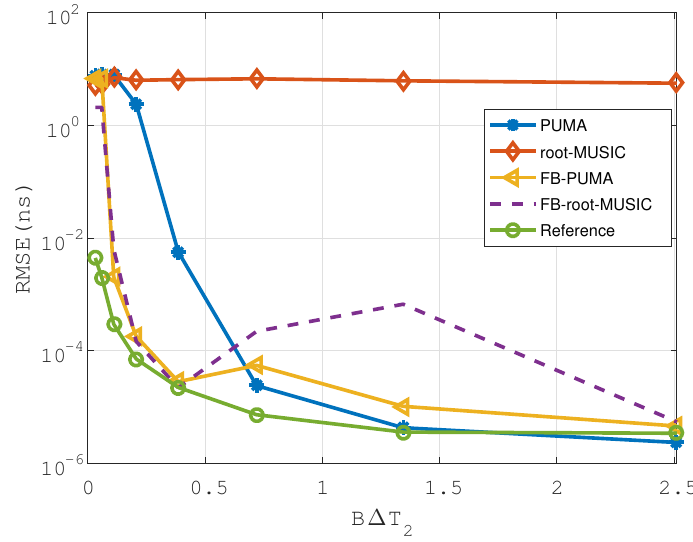
Figure 6. RMSE versus B ∆ T 2 , Scenario 2, SNR = 25dB.